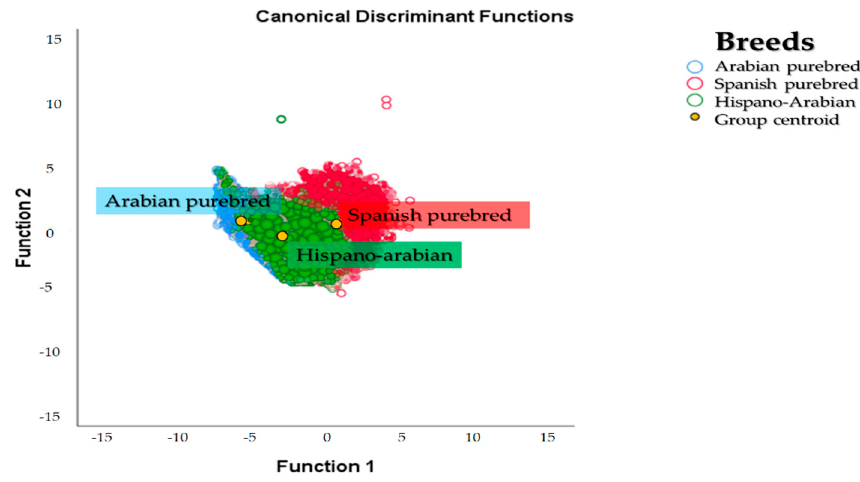
Figure 5. Territorial map depicting the results of the canonical discriminant analysis on the individuals comprising the Arabian purebred (PRá), Spanish purebred (PRE) and Hispano-Arabian (Há) horse breeds.